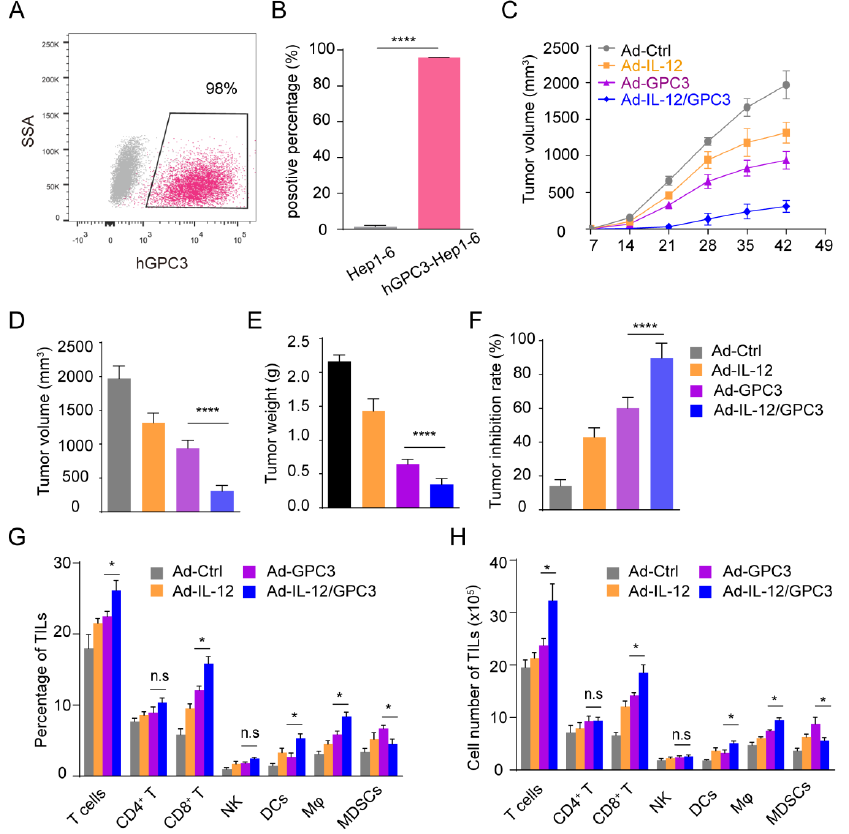
Figure 2. Therapeutic effects of Ad-IL-12/GPC3 vaccine in a subcutaneous tumor model. ( A ) The ratio of hGPC3 expression was determined by flow cytometry in Hep1-6 cells infected with hGPC3 lentivirus. Mice were inoculated subcutaneously at the right flank with 5 × 10 6 hGPC3-Hep1-6 cells. Seven days later, mice were intramuscularly immunized with various vaccines. ( B ) Tumor growth was monitored once a week following the vaccination. ( C ) Tumor volumes. ( D ) Tumor weights. ( E ) Tumor inhibition rate. ( F ) Mice were sacrificed on the 42nd day after tumor inoculation. ( G , H ) The frequencies and total numbers of T, CD4 + T, CD8 + T, NK, DCs, macrophages, or MDSCs in TILs were analyzed. The experiments were performed with five mice per group. Data shown are representative of three experiments. Data means ± SD. The different significance was set at *, p < 0.05; ****, p < 0.001; n.s, not